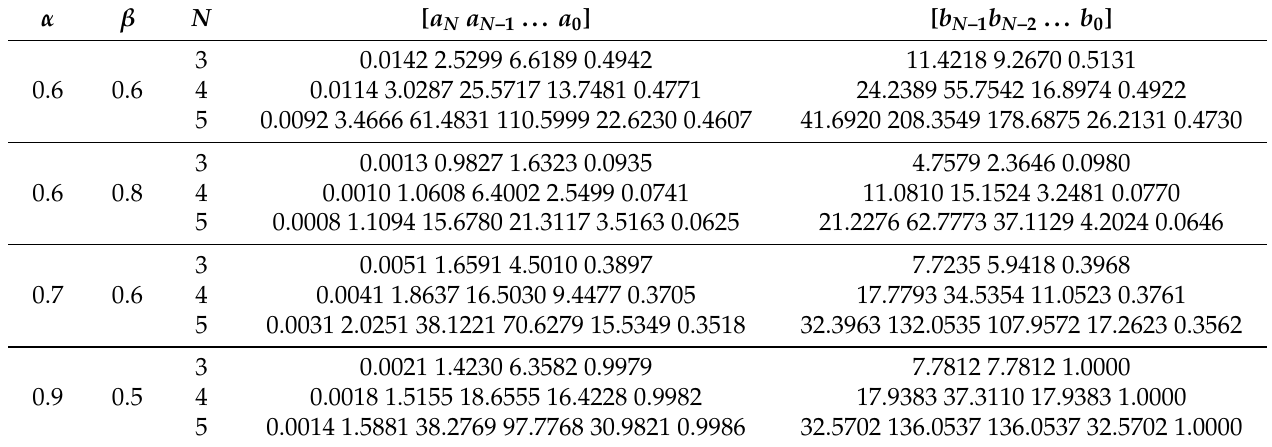
Table 2. Optimal coefficients of the proposed FLPFs for different values of α , β , and N